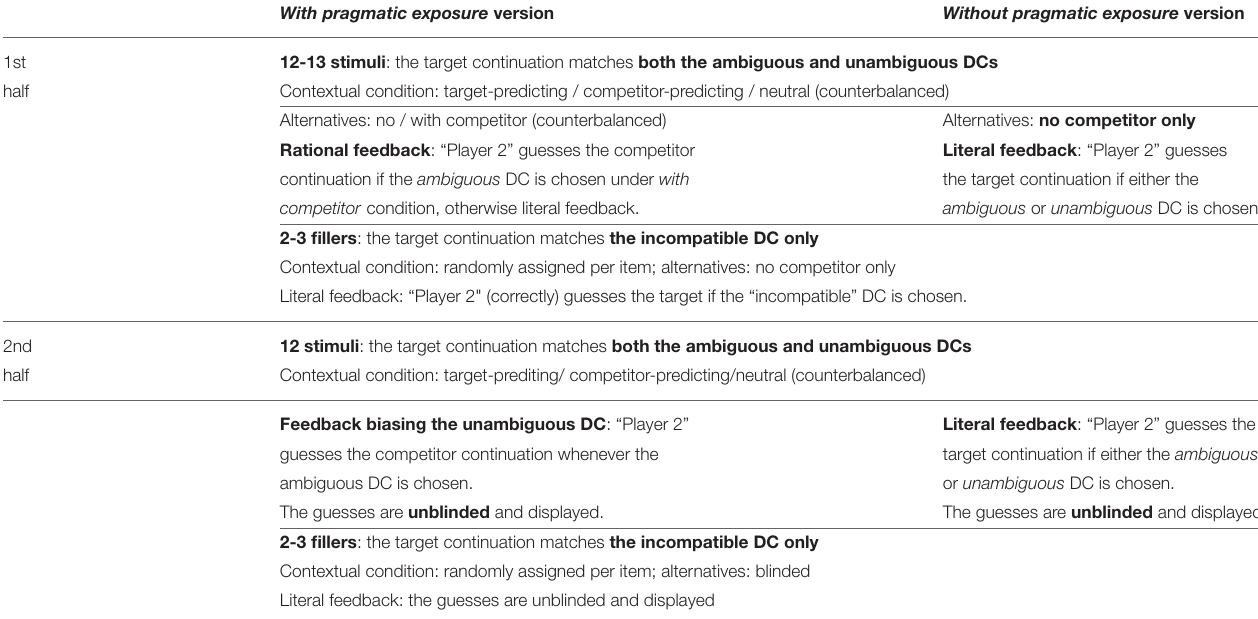
TABLE 5 | Task structure of Experiment 2. With pragmatic exposure version Without pragmatic exposure